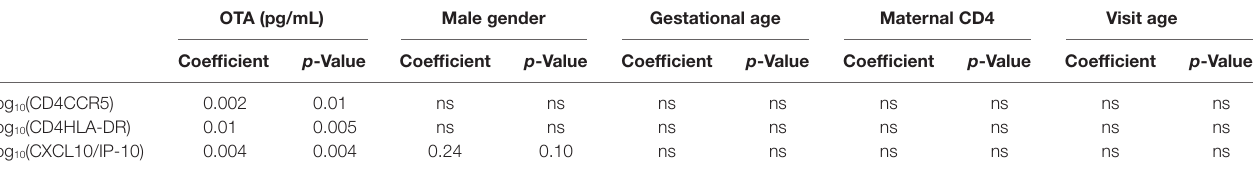
Coefficient and p-values for variables with p < 0.1 for the minimum, stepwise multivariate analyses. NS: p >